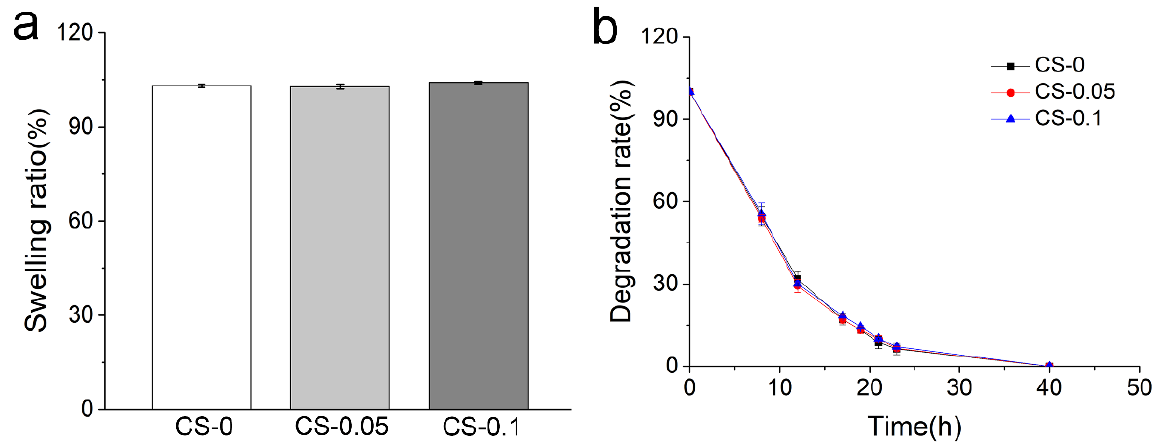
Figure 3. ( a ) Swelling ratios and ( b ) degradation rates of different hydrogels.